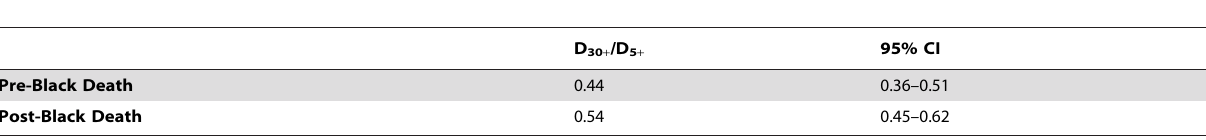
Table 2. D 30 + /D 5 + values and their 95% confidence intervals for the pre- and post-Black Death samples.